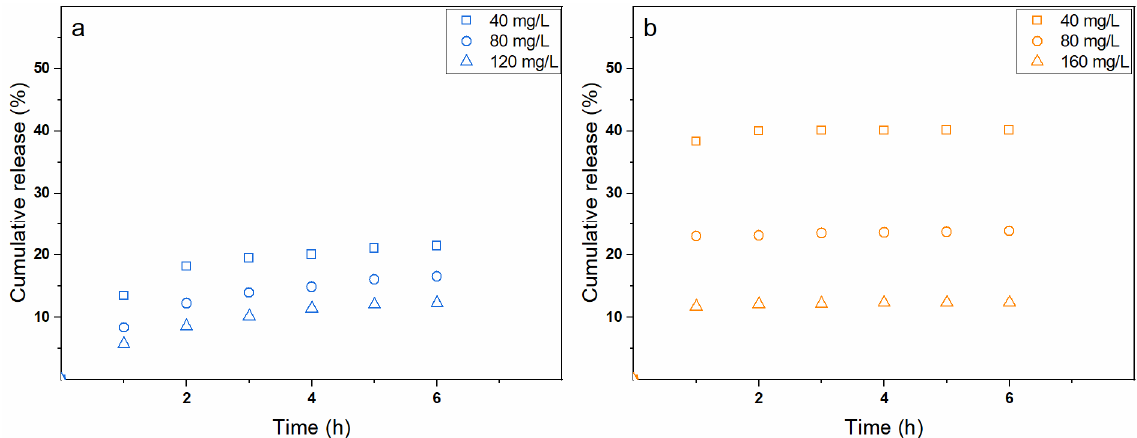
Figure 8. Cumulative release from the physically crosslinked chitosan membranes in PBS after their loading in ( a ) MB or ( b ) MO solutions with different dye concentration (i.e., 40, 80, and 160 mg/L).